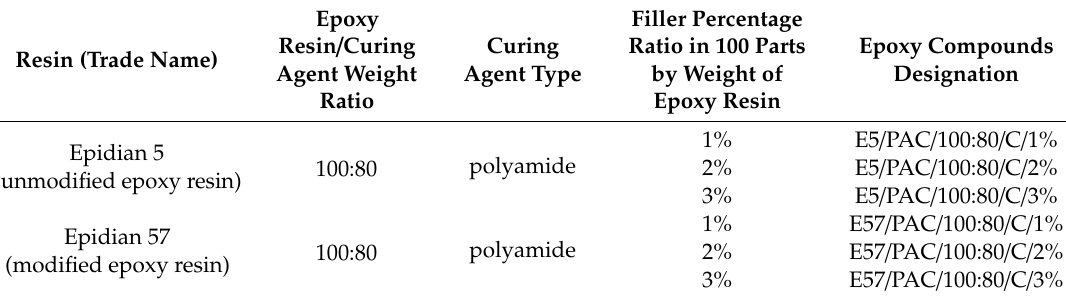
Table 2. Modified epoxy compounds with activated carbon (C) as the